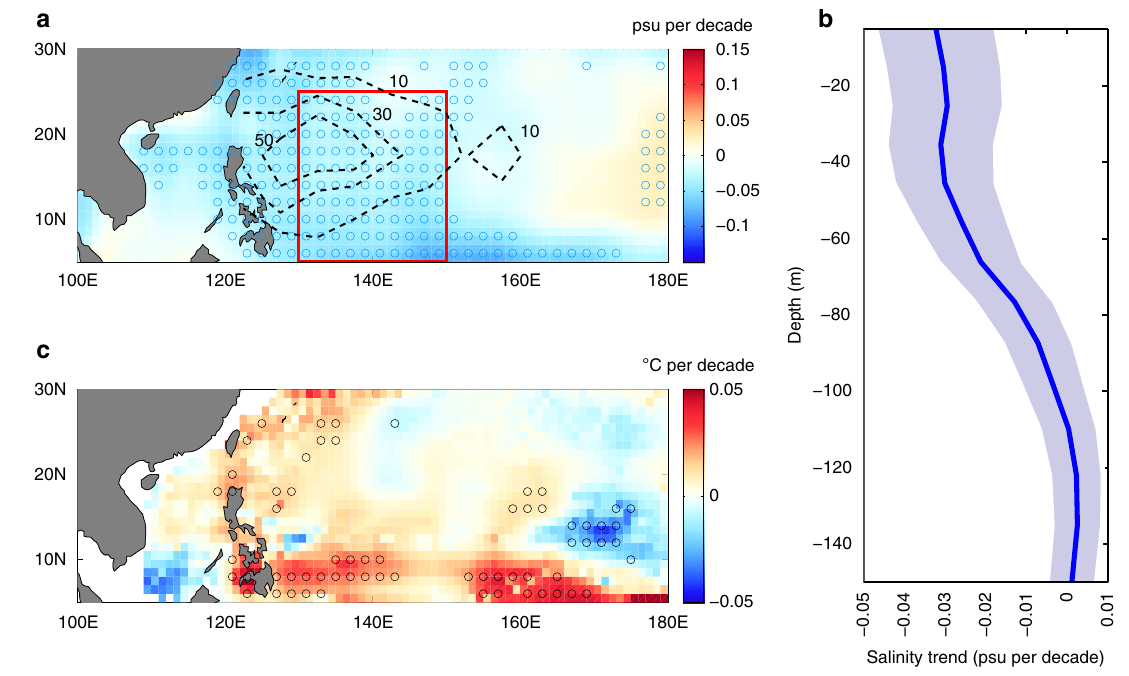
Figure 1 | Observed trends in upper-ocean salinity and salinity impact on super typhoon cold wakes for 1958–2013 based on EN4. ( a ) Trends in typhoon-season (June–November) mean sea surface salinity in psu per decade with dashed-black contours, at intervals of 20 units, overlaid representing the number of 6hourly super typhoon (STY) track locations. The box in red indicates the study region: 130 (cid:2) E–150 (cid:2) E and 5 (cid:2) N–25 (cid:2) N. ( b ) Trends in typhoon- season mean subsurface salinity, averaged over the region 130 (cid:2) E–150 (cid:2) E and 5 (cid:2) N–25 (cid:2) N (see box in a ), in psu per decade. The line represents the median trend value and the shaded area indicates the 95% confidence intervals, estimated using a linear regression. ( c ) Trends in typhoon-season (June–Nov) mean salinity contribution to cold wakes in (cid:2) C per decade. In a , c , locations with statistically significant trends are marked with